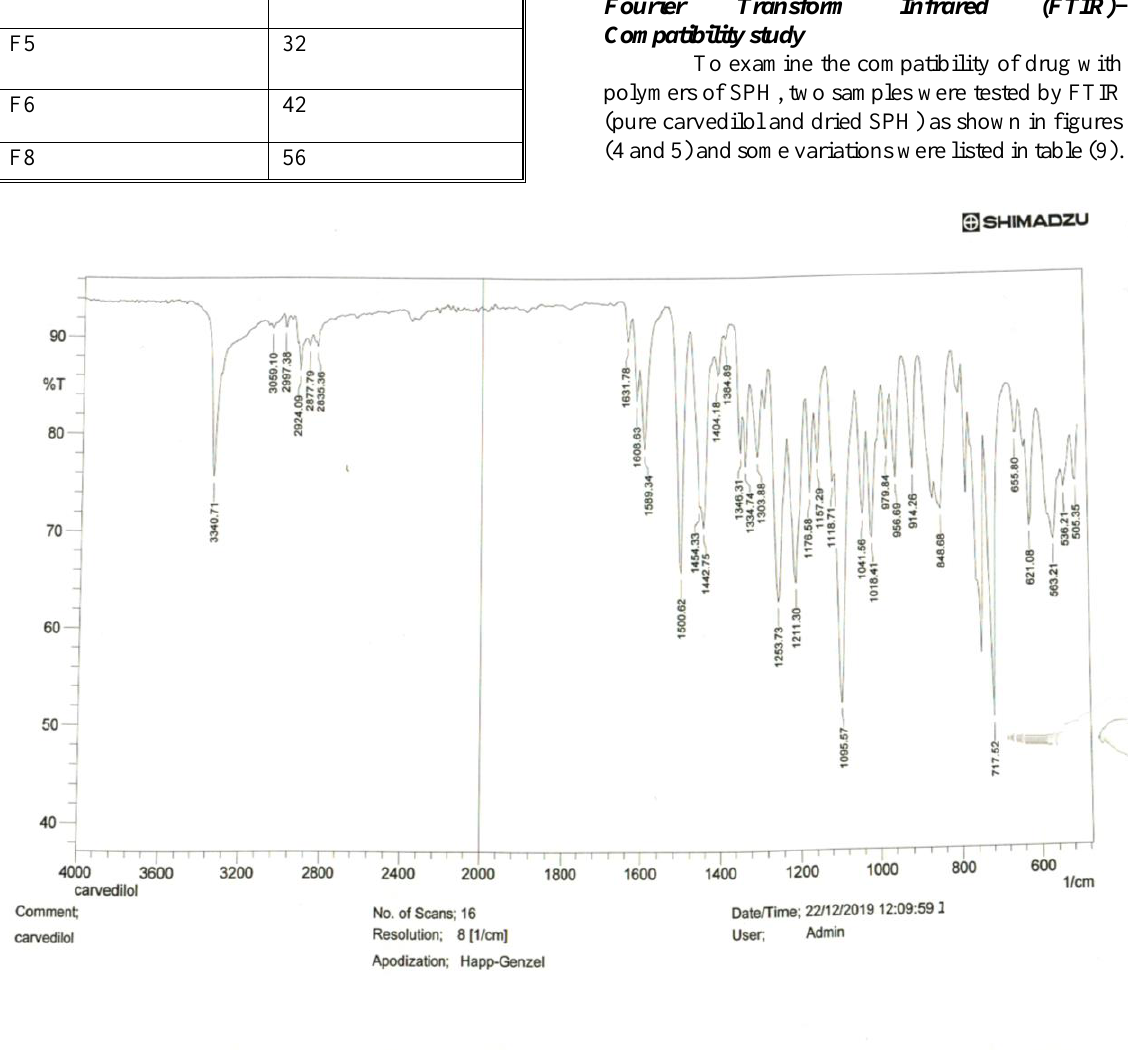
Figure 4. Pure carvedilol FTIR spectrum